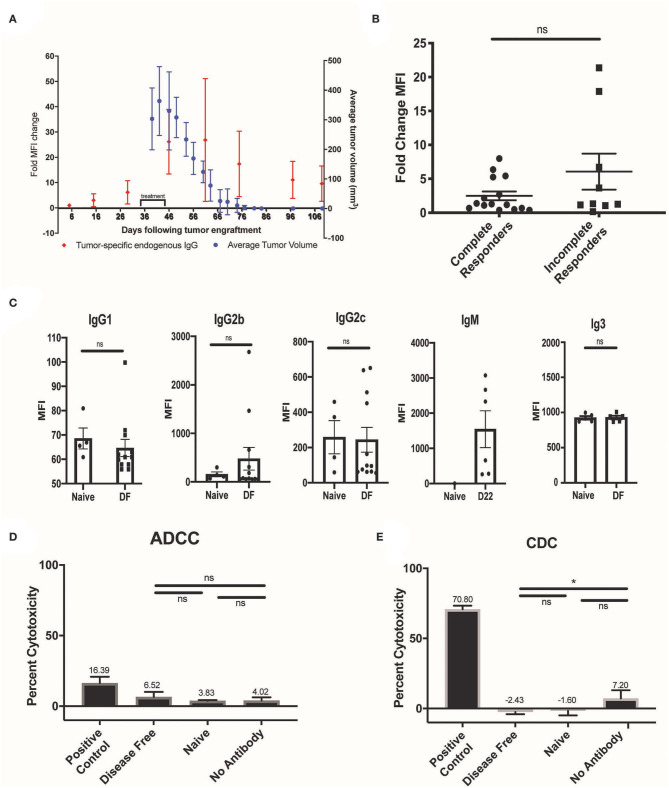
Timing, isotype, and function of the endogenous antibody response to RT + IT-IC + anti-CTLA-4. (A) Serum was collected from mice (N = 5) treated with RT + IC + anti-CTLA4 before, during, and after treatment and was tested for anti-tumor antibody binding to B16 melanoma (red dots). Corresponding mean tumor volume (for these same mice, N = 5) is represented by the blue dots with standard error of the mean (SEM). (B) Fold change MFI of serum collected from tumor bearing mice prior to treatment and at D22 after treatment in B78 tumor bearing mice. All mice were treated with RT + IC + anti-CTLA4; data shown represents samples from 4 separate experiments (n = 16 complete response, n =9 incomplete responses). Response to treatment was assessed at D90 after radiation, and serum was collected for analysis at this time. There was no significant difference in the fold change of MFI between the complete responders and the incomplete responders (p > 0.05). (C) DF, post re-challenge serum was analyzed by flow cytometry for the presence of IgG1, IgG2b, IgG2c, and IgG3 antibody subclasses that bound to B16, and is represented as MFI. D22 serum was analyzed by flow cytometry for the presence of IgM antibody that bound to B16, and is represented as MFI. D22 was chosen due to the propensity for IgM to rise early during the immune response. (D) ADCC capacity of disease free serum was tested using 51chromium-release assays with B16 GD2+ melanoma cells, murine effectors (effector to target ratio 50:1), and serum (n = 3 for naive, n = 15 for disease free), or ch14.18K322a (positive control) was added. Antitumor functionality was quantified by percent cytotoxicity and is represented by the mean and SEM for data obtained using 50 effector cells per target. (E) CDC was also measured, using anti-GD2 antibody 14G2a as a positive control. Data in (D,E) represent one of two replicates. P < 0.05 were considered significant and are indicated in figures *p < 0.05, NS, non-significant (p ≥ 0.05).